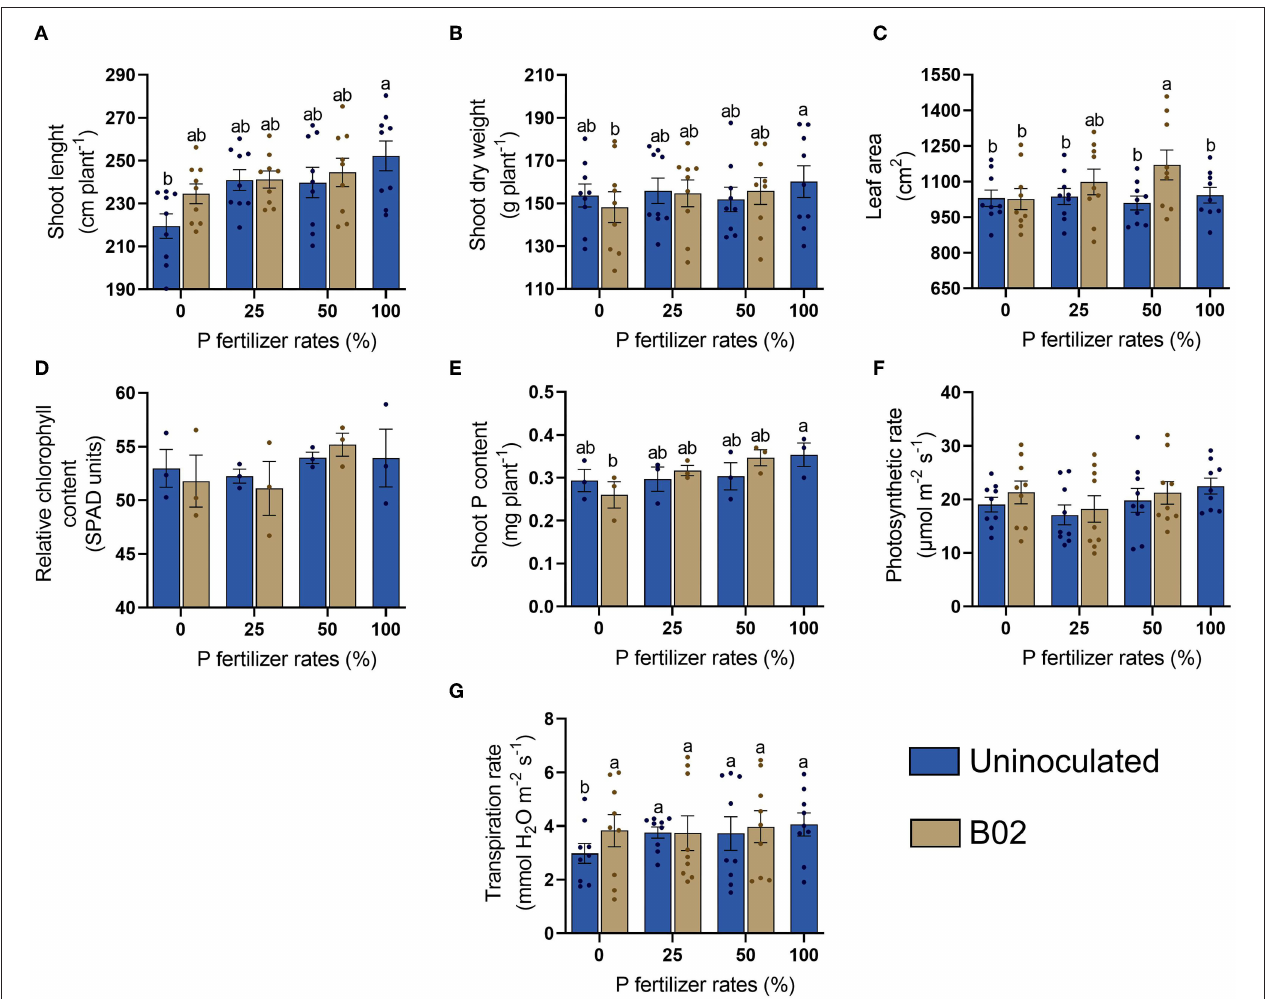
FIGURE 6 | Influence of inoculation with Rhizobium sp. B02 on shoot length (A) , shoot dry weight (B) , leaf area (C) , relative chlorophyll content (D) , shoot P content (E) , photosynthetic rate (F) , and transpiration rate (G) of the yellow endosperm genotype of maize at the vegetative stage of the tassel (VT). Except for relative chlorophyll and shoot P contents (three measurements), means and standard errors result from three replicates and three independent repetitions (nine measurements). Different letters are indicators of significant differences according to Tukey’s test ( p <